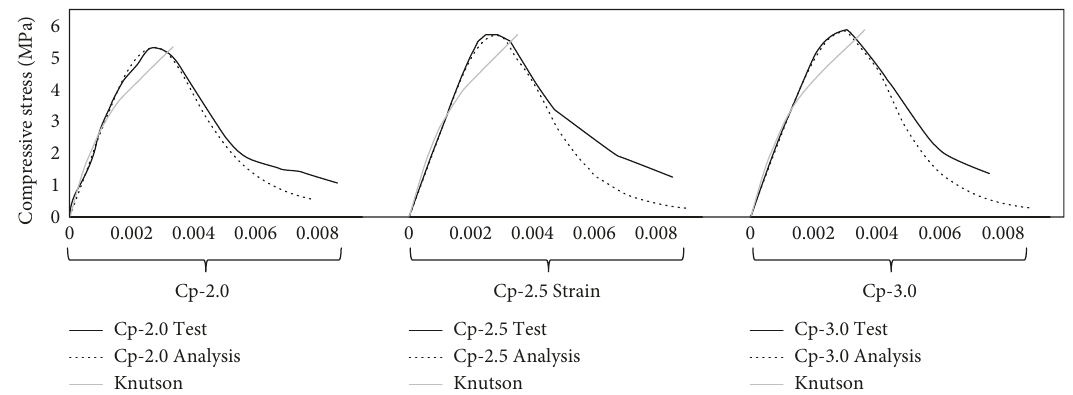
Cp-2.0 Cp-2.5 Strain